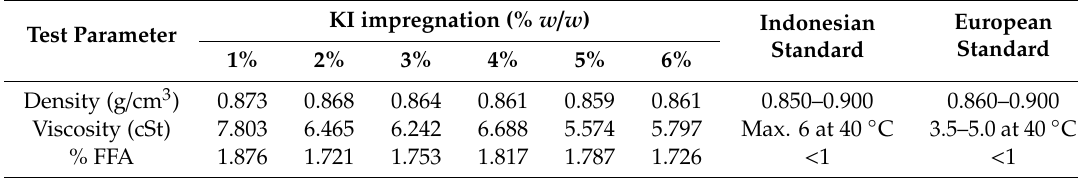
Table 3. Biodiesel characteristic using the HAP / KI catalyst.